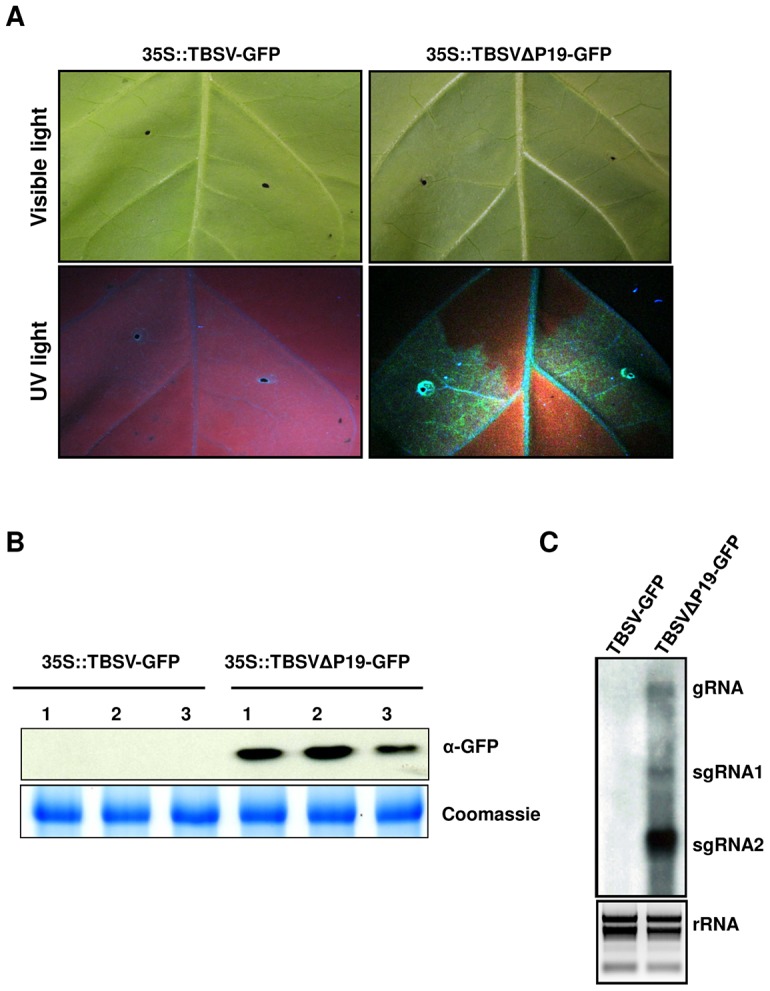
P19 is required for extreme resistance of N.
tabacum against TBSV.(A) Leaves of 5 weeks old N. tabacum cv. Xanthi plants were infiltrated with Agrobacterium expressing TBSV-GFP or TBSVΔP19-GFP. Pictures of infiltrated leaves were taken 5 dpi under transmitted light and UV. (B) GFP accumulation in infiltrated leaves from three independent plants. Western analysis was carried out using an anti-GFP antibody. Coomassie staining of the same extracts is shown to demonstrate equal protein loading. (C) Northern analysis of TBSV-GFP and TBSVΔP19-GFP RNA accumulation in infected plants at 5 dpi, using a GFP DNA fragment as a radioactive probe. Viral genomic and subgenomic RNAs are indicated; ribosomal RNA was used to demonstrate equal RNA loading. Experiments were repeated three times and showed similar results.